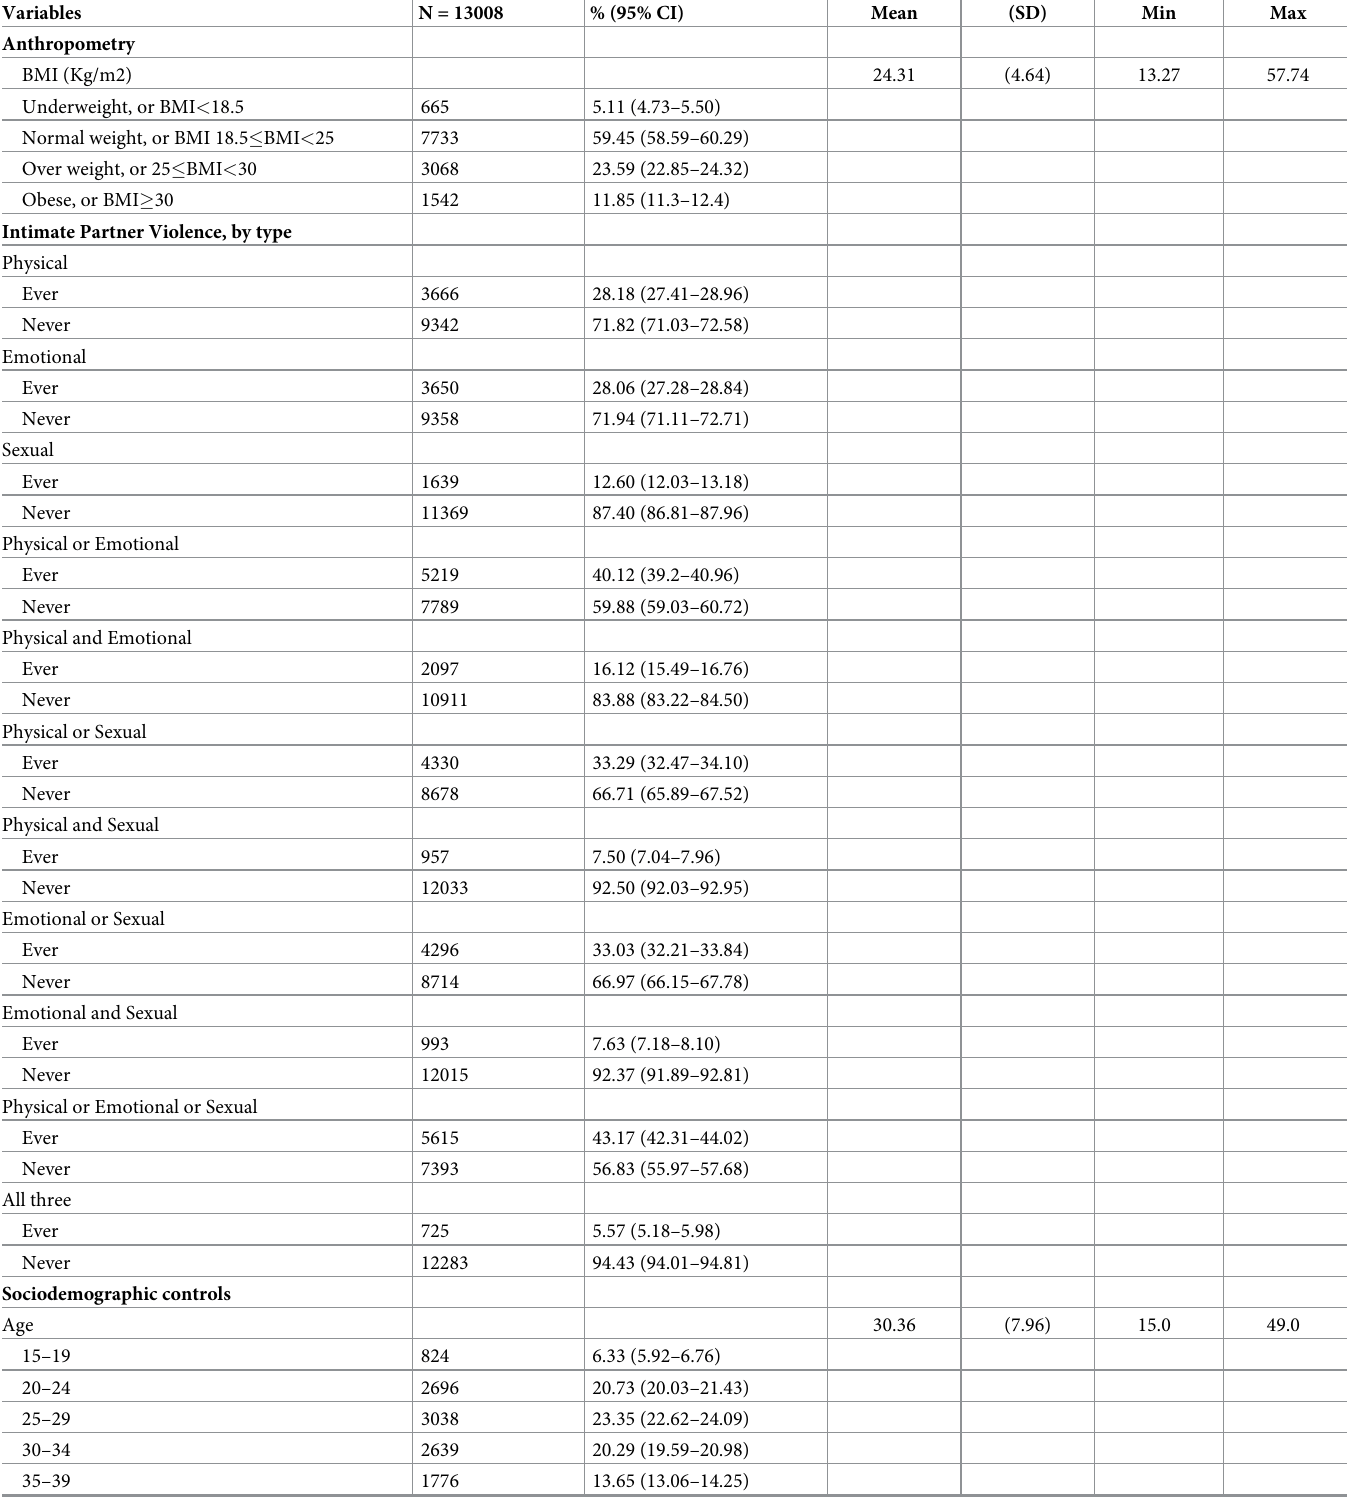
Table 1. Percentage distribution of the characteristics of women (15–49 years) in Zimbabwe, pooled data, 2005–2015 ( n =